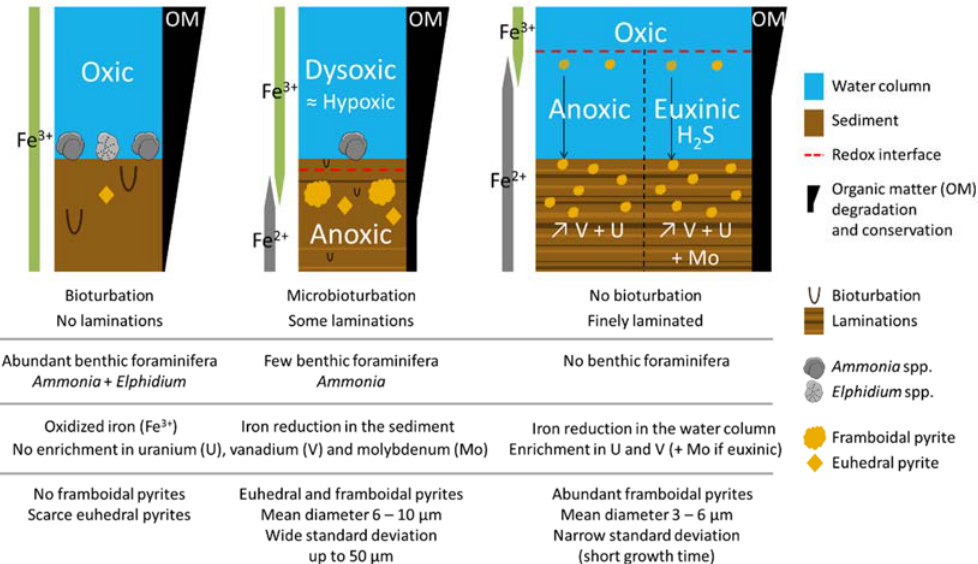
Figure 1. Schematic description (not at scale) of proxies used in the literature and investigated in this work to determine the oxygenation level of bottom waters: presence or absence of bioturbation, laminations [15] and benthic foraminifera [16]; organic matter content [17]; enrichments of trace metals such as vanadium (V), uranium (U) and molybdenum (Mo) [18]; iron redox state; abundance and size of framboidal pyrites depending on the position of the redox interface, i.e., the transition between well ‐ oxygenated water and hydrogen ‐ sulphide rich water [19,20]. The relevance of the proxies used for our case study is discussed in the Discussion section.